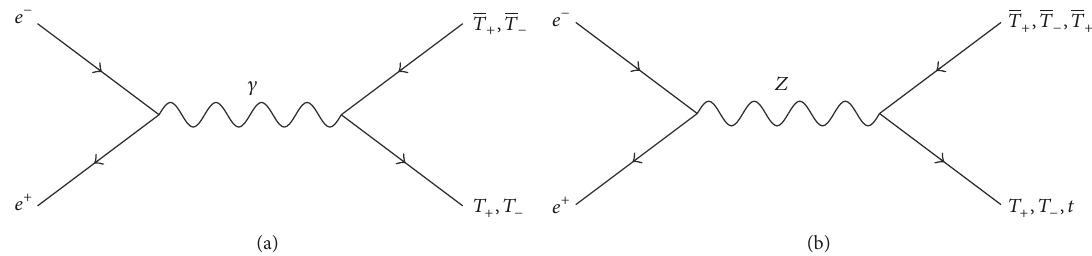
Figure 1: Feynman diagrams of the top partner production at 𝑒 + 𝑒 − collider.